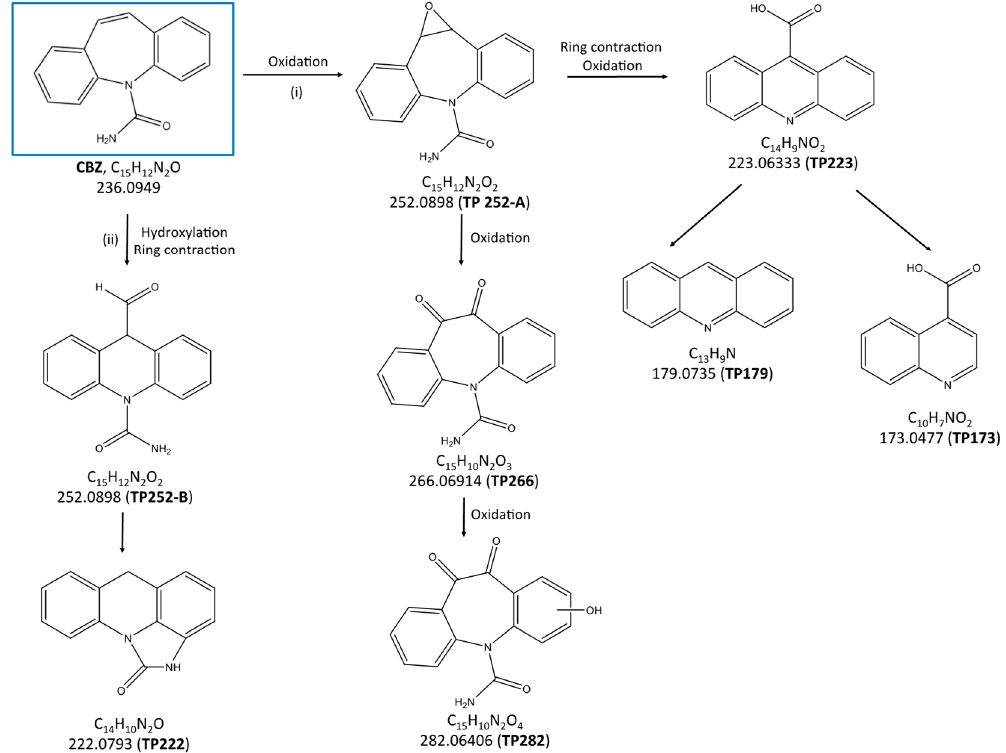
Figure 5. Proposed degradation pathway of carbamazepine degradation by photoelectrocatalysis obtained on the basis of the identified transformation products (TPs).